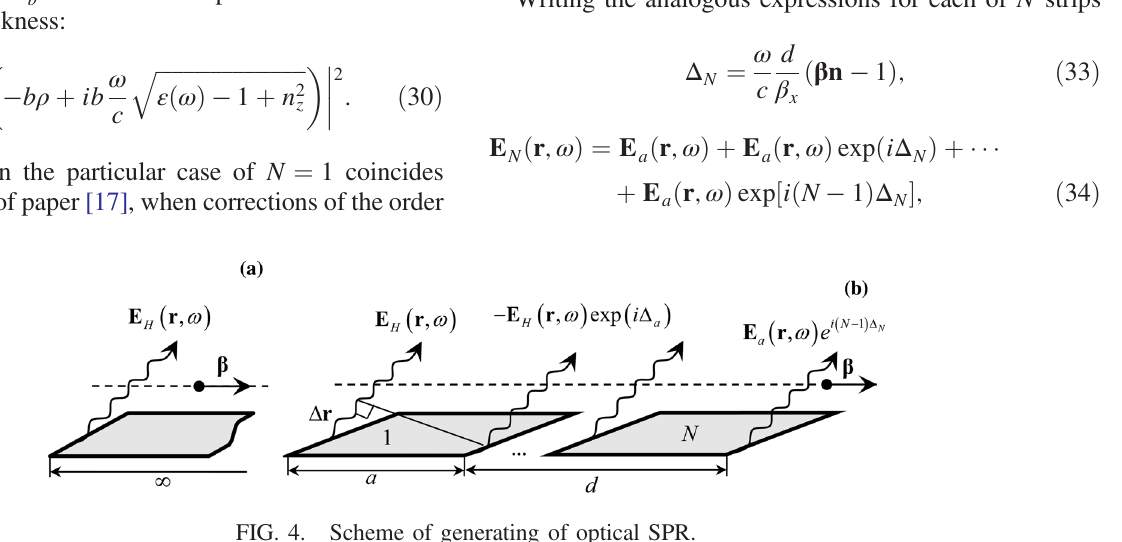
FIG. 4. Scheme of generating of optical